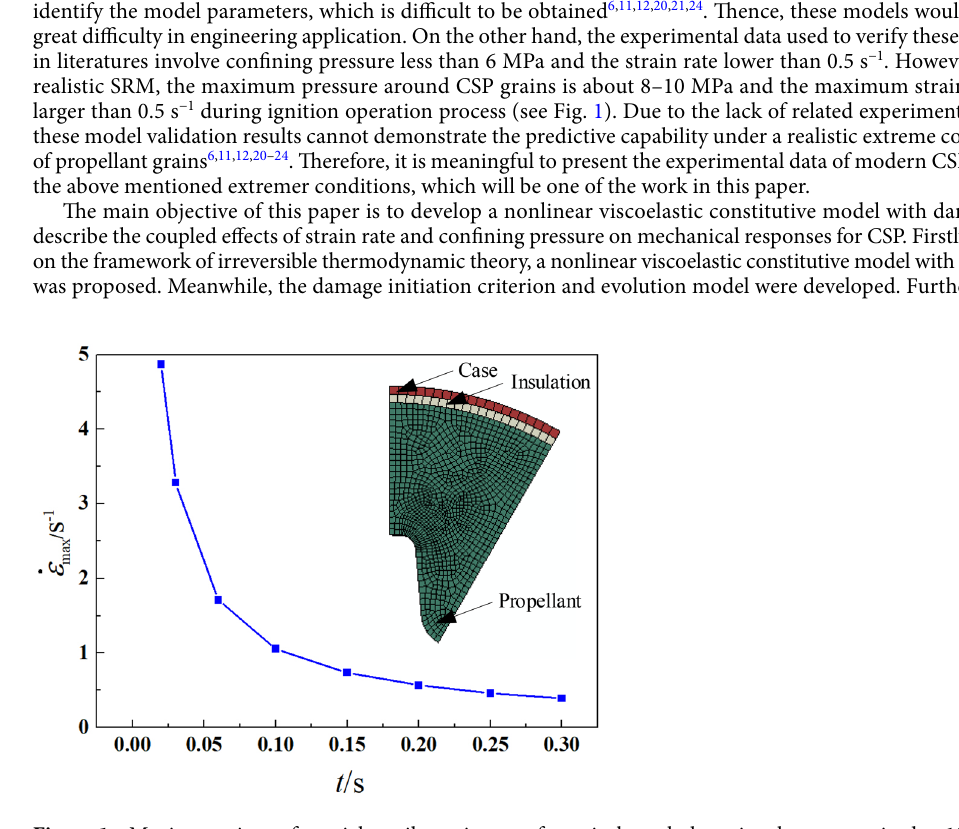
Figure 1. Maximum circumferential tensile strain rate of a typical star-hole grain when pressurized to 15 MPa at different times (0.03–0.3 s) calculated by Abaqus